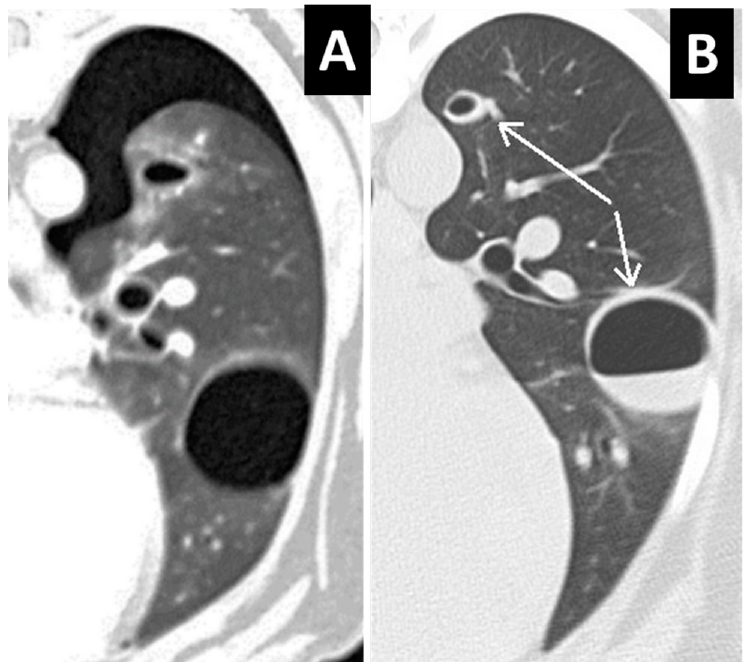
Figure 7. Comparison of computed tomography (CT) images of the left lung in a traumatized dog with Type 2 and Type 4 lung lacerations. ( A ) The first CT examination showed two cystic, air-containing lesions and ipsilateral pneumothorax (without rib or vertebral fractures). ( B ) After 5 days, CT showed air–fluid levels in both lesions and a small amount of air visible in the pleural cavity.